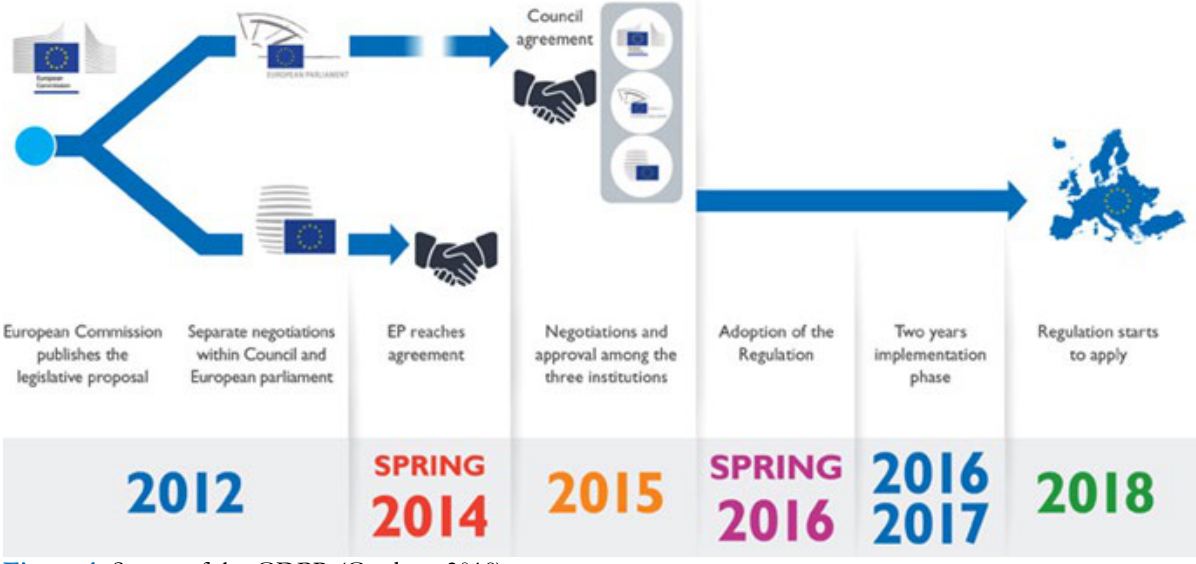
Figure 1. Stages of the GDPR (Goubau,